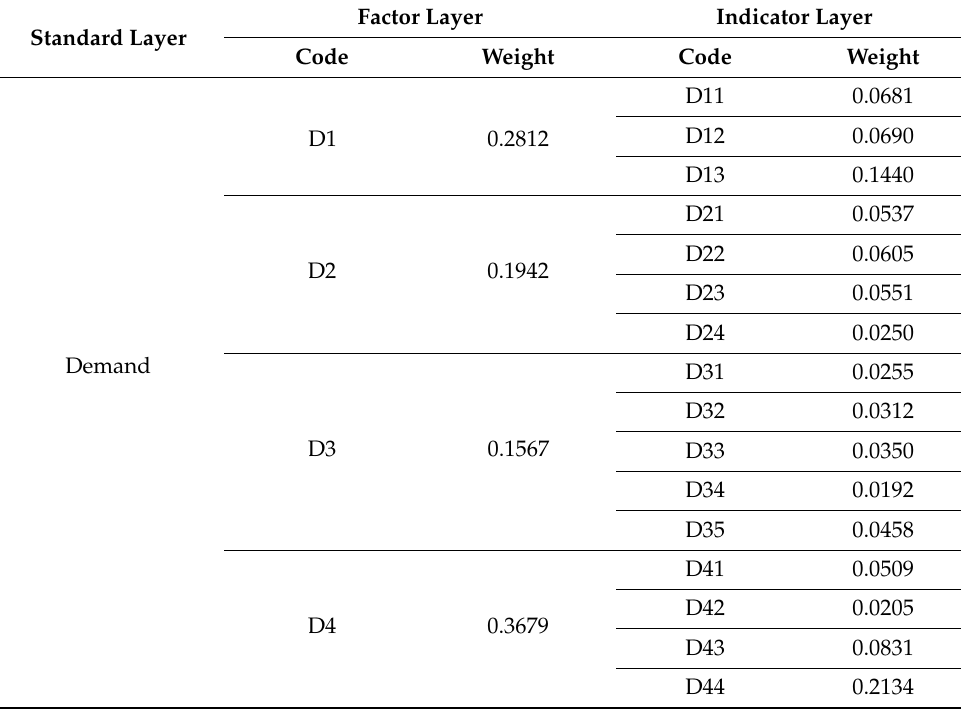
Table 3. Entropy weights of demand system.